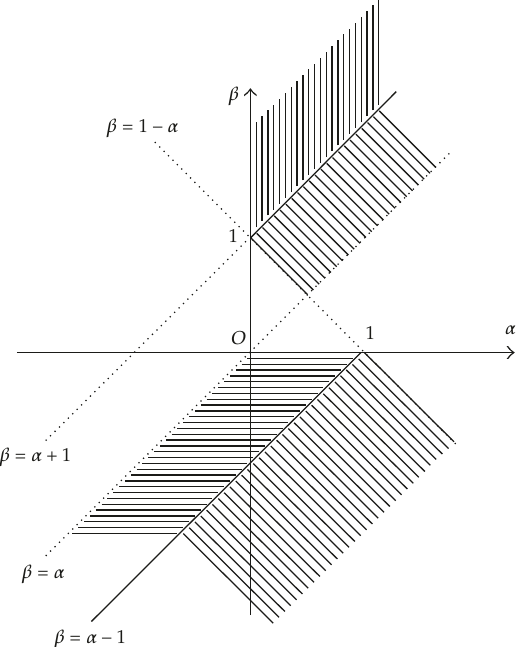
Figure 4: (cid:3) α,β (cid:5) -domain where q α,β (cid:3) t (cid:5) is decreasing on (cid:3) 0 , ∞ (cid:5)